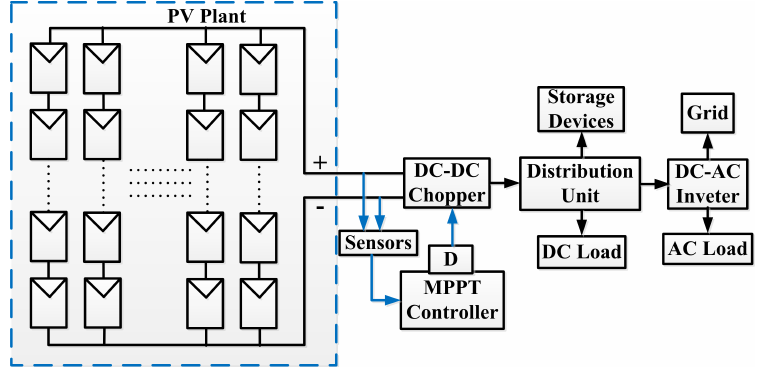
Figure 2. Centralized PV plant with MPPT